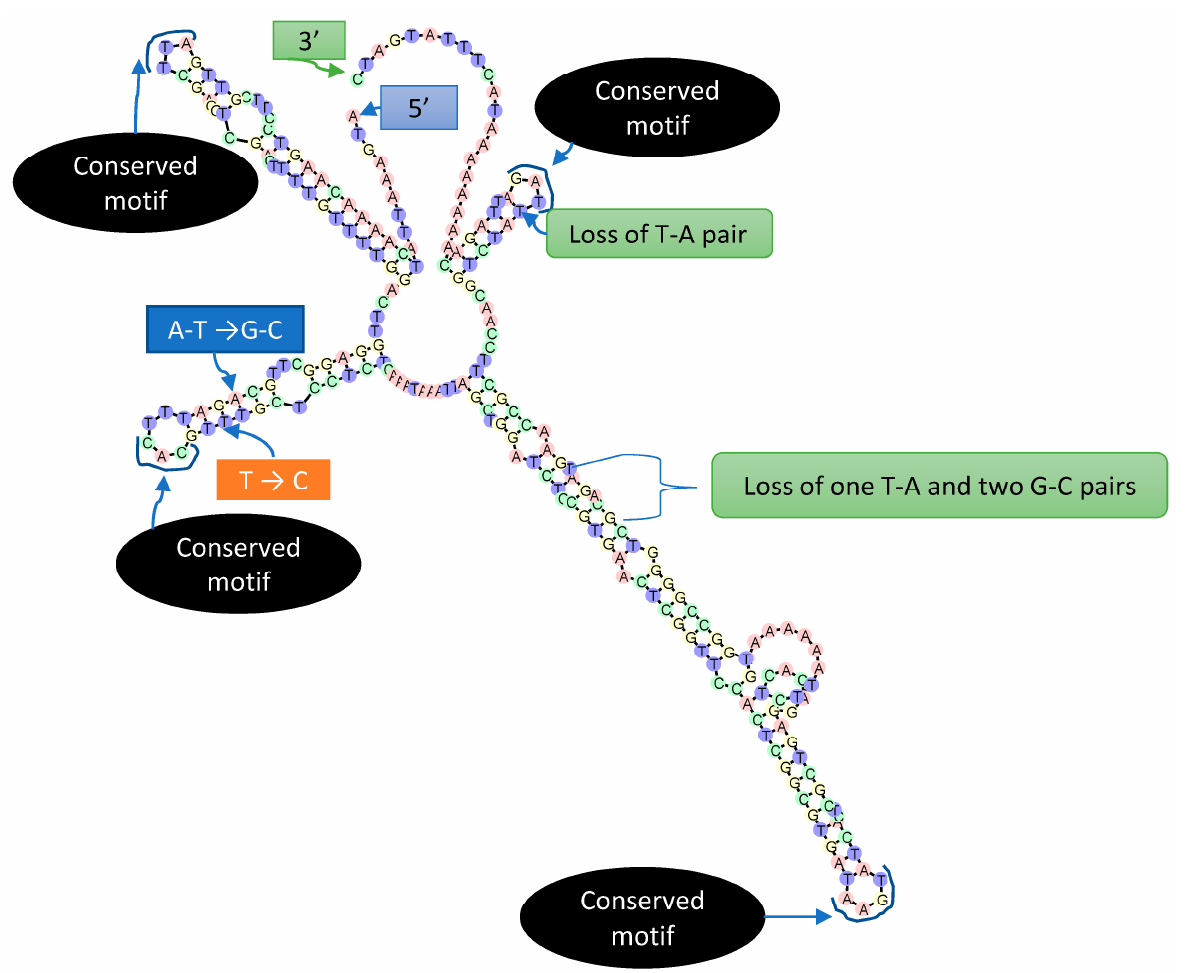
Figure 7. The ITS2 secondary structure of Ceratobasidium anceps , isolate CBS 152.32 (GenBank Acces- sion MH855251). as predicted by the ITS2 DB ‘Predict’ utility. The nucleotides are highlighted in green (C), orange (G), violet (T), and pink (A). The structural changes in ITS2 of Rhizoctonia tuliparum isolate I-399 (GenBank Accession KX767078) are indicated by compensatory base change (CBC) in the blue box, the hemi-compensatory base change (hCBC) in the orange box, and the loss of base pairs in light green boxes. The conserved terminal loop sequences are marked with curved lines and indicated in black oval boxes in all four helices.